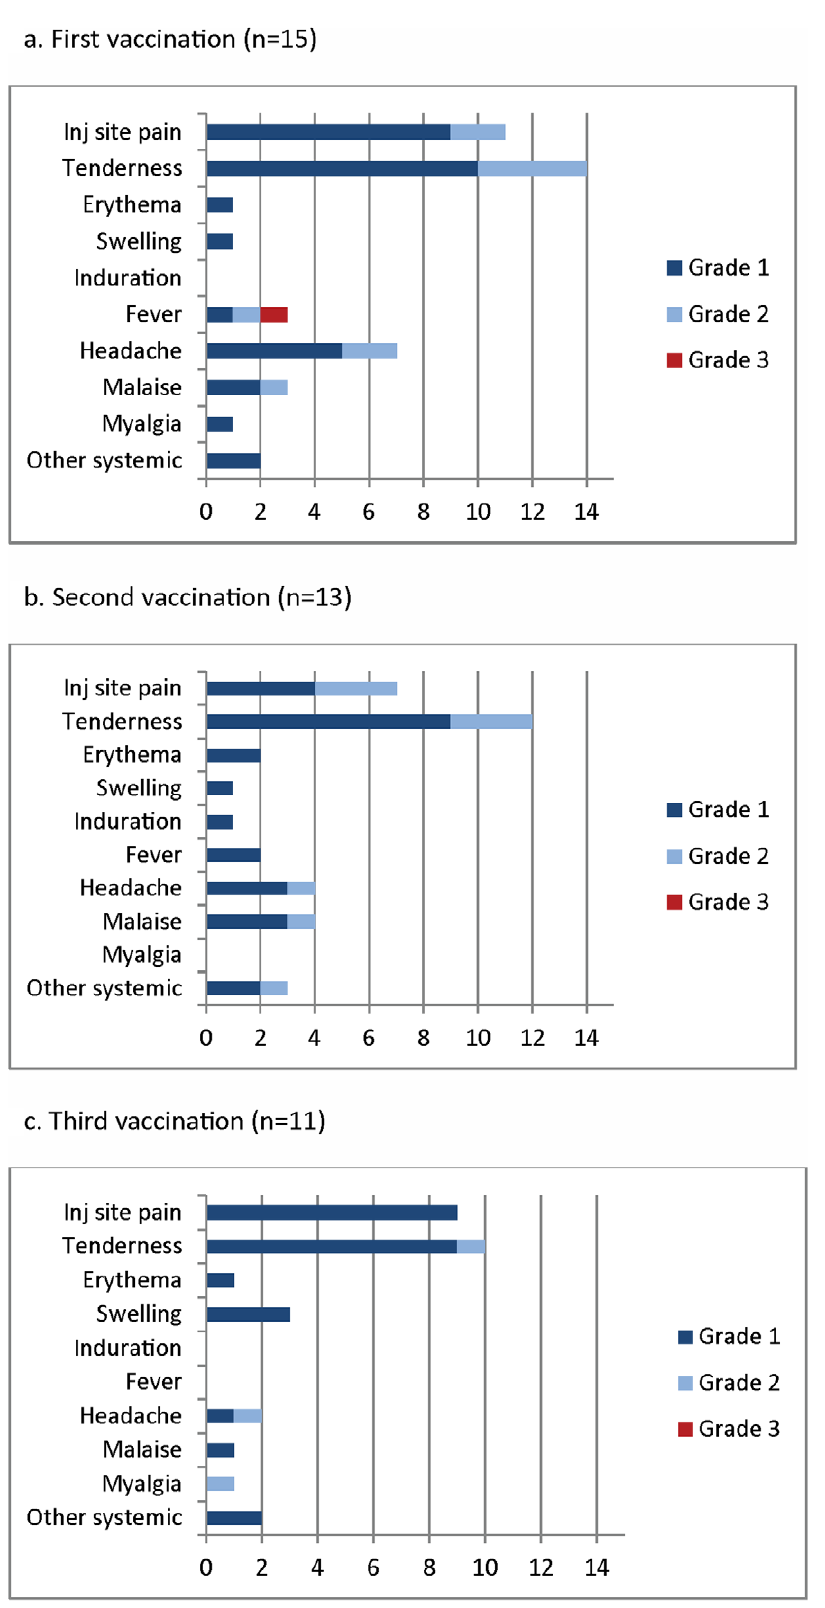
Figure 3. Local (injection site pain, tenderness, erythema, swelling, induration) and related systemic adverse events after first, second and third vaccinations in the high dose group. The x-axis shows the number of participants experiencing adverse events, with the highest severity event for each participant after each vaccination shown. Other systemic adverse events in both high and low dose groups were: diarrhea (1 severe, 2 mild), abdominal pain, nausea, and cough (all mild or moderate). doi:10.1371/journal.pone.0046094.g003 PLOS ONE |